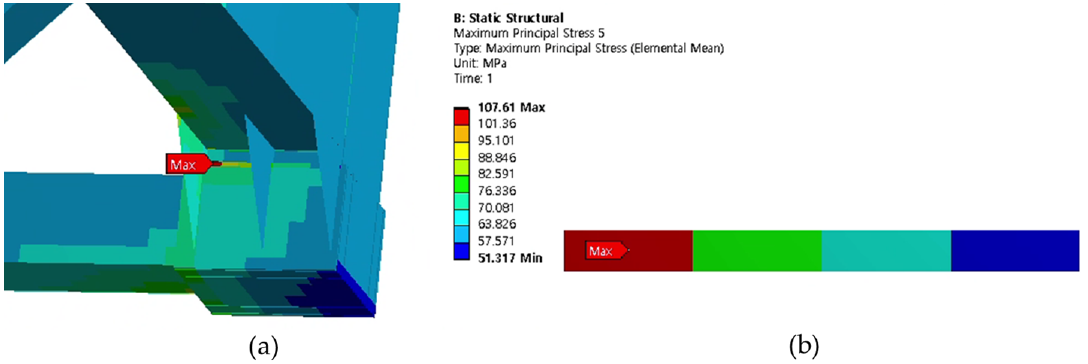
Figure 8. Case 2 principal stress distribution. ( a ) Entire computational domain showing region of maximum stress (position 2). ( b ) Position 2 element analysis result in detail.